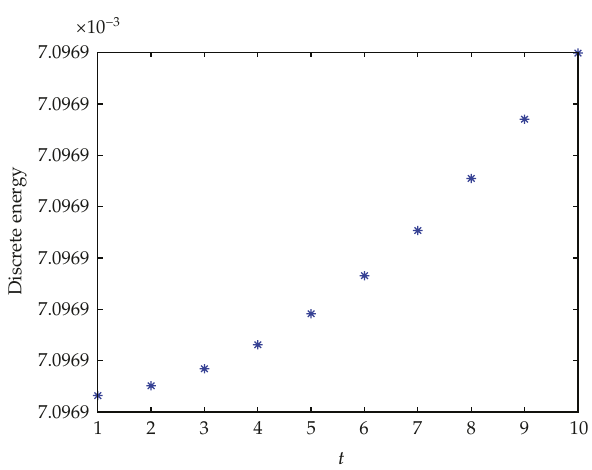
Figure 2: Energy of scheme (cid:5) 3.1 (cid:6) when h (cid:7) 1 / 32 and τ (cid:7) 0 .